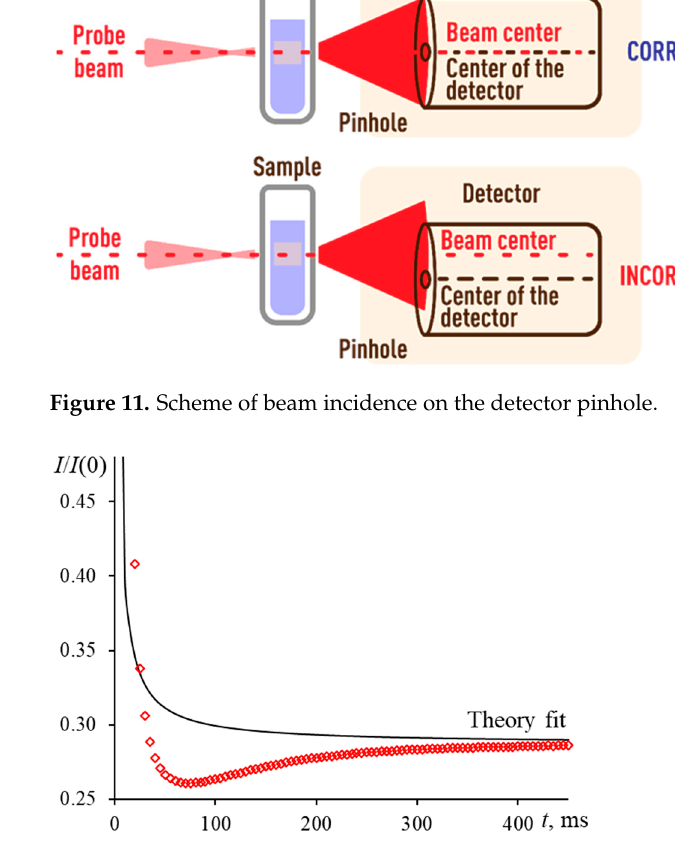
Figure 12. The transient curve of an aqueous solution of ferroin (2.5 µmol/L) when the intensity of the probe laser beam passing through the detector pinhole is not the maximum; narrow-focused configuration ( 𝜔 (cid:3032)(cid:2868) = 33 µm, Figure 1, Table 3).